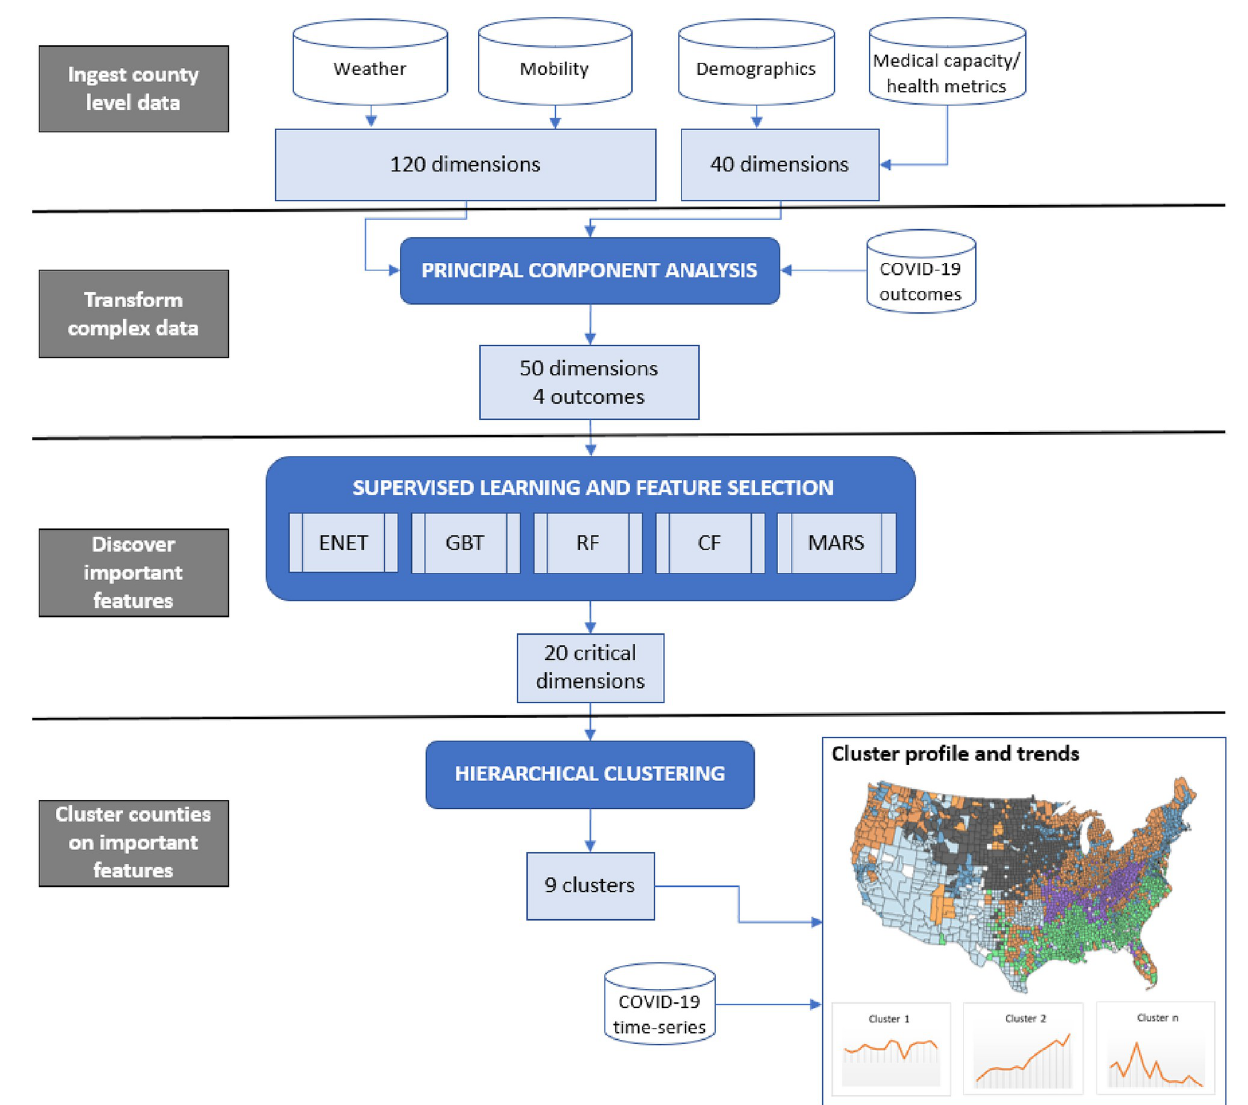
Fig 1. Machine learning to enhance county-level COVID-19